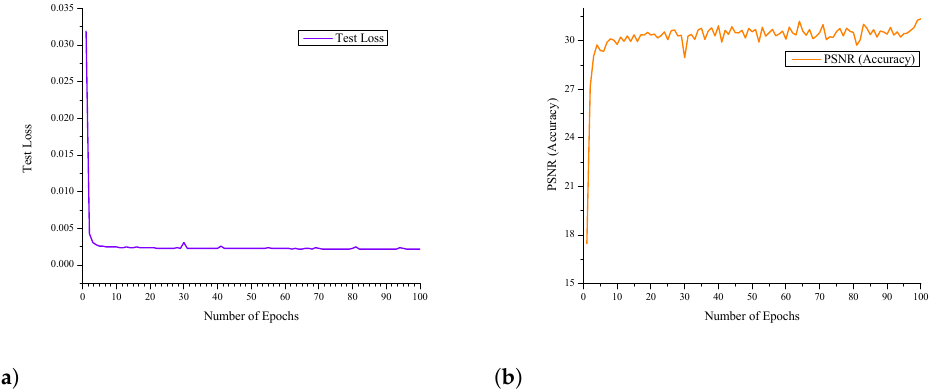
Figure 8. Curves of testing loss and accuracy against the number of the epoch. ( a ) test loss as a function of epochs ( b ) test accuracy as a function of the